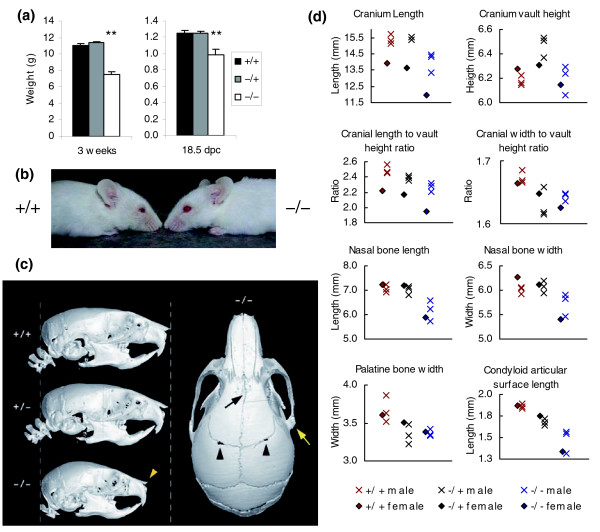
MommeD10-/- mice are smaller than their littermates and display craniofacial abnormalities. (a) Body weight was measured for 46 MommeD10+/+, 102 MommeD10-/+ and 10 MommeD10-/- weaners (3 weeks), and 11 MommeD10+/+, 22 MommeD10-/+ and 5 MommeD10-/- embryos (18.5 dpc). Histograms show mean and SEM. (b) Craniofacial abnormalities in adult MommeD10-/- mice. MommeD10-/- mice display shorter snouts than age and sex-matched wild-type littermates. (c) Three-dimensional reconstruction of skull microCT data from 4-week-old male mice reveals distinct anomalies in homozygous Baz1B mice. Left side: lateral views show the overall size and shape of heterozygous skulls is similar to that of wild-type skulls, whereas skulls of homozygotes were around 20% shorter. Homozygous skulls showed variable anomalies, but consistently had a bulbous appearance, and a short, flattened, or upwardly angulated nasal bone (yellow arrowhead). Slight angulation of the nasal bones was also noted in one heterozygote. Right side: dorsal view of the homozygote skull shown on the left side showing the abnormal shape and more rostral connection of the zygomatic process with the squamosal bone (yellow arrow), skewing of the midline frontal bone suture (black arrow) and minor bilateral anomalies of the frontal:parietal suture (black arrowheads). (d) Twenty cranial landmarks and nine mandibular landmarks (based on those of Richtsmeier [49]) were located on each of nine skulls and inter-landmark measurements recorded. The mean value of each measurement, including analysis of cranium height:width and cranium length:height ratios, was compared between homozygous, heterozygous and wild-type animals.